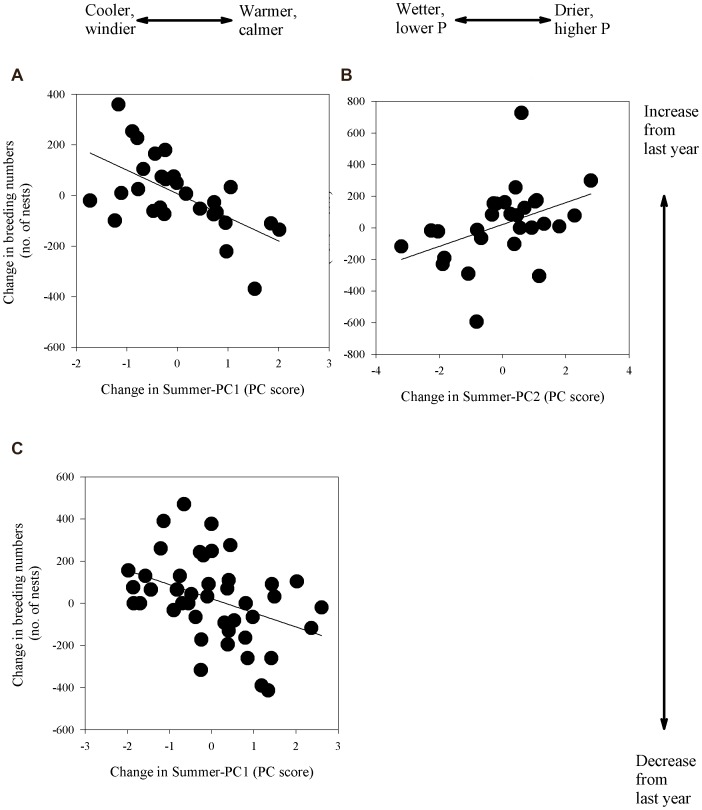
Relationship between summer weather and breeding numbers (no.of nests) 3 years later.Shown are three common eider colonies in Iceland 1977–2007 (A, B) and 1961–2007 (C). Graphs on the left-hand side have Summer-PC2 on the X-axis whereas graphs on the right-hand side have Summer PC1 on the X-axis (see explanations on top of each column of graphs). Note the differing scales on y- and x axis.